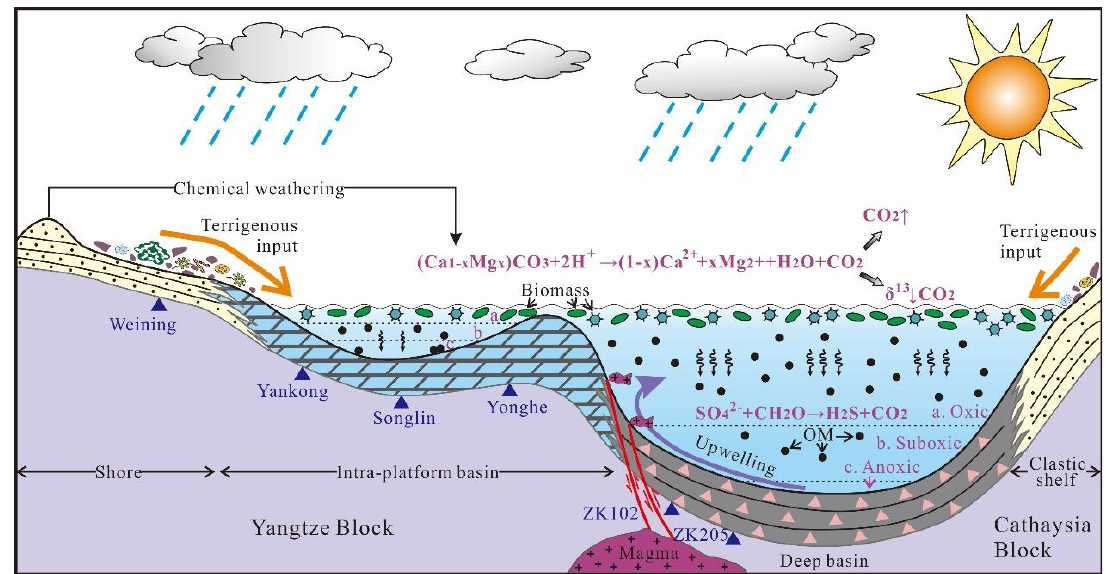
Figure 13. Schematic sketch illustrating the organic matter accumulation mechanism in the Upper Yangtze region during the deposition of the Early Cambrian black shale.